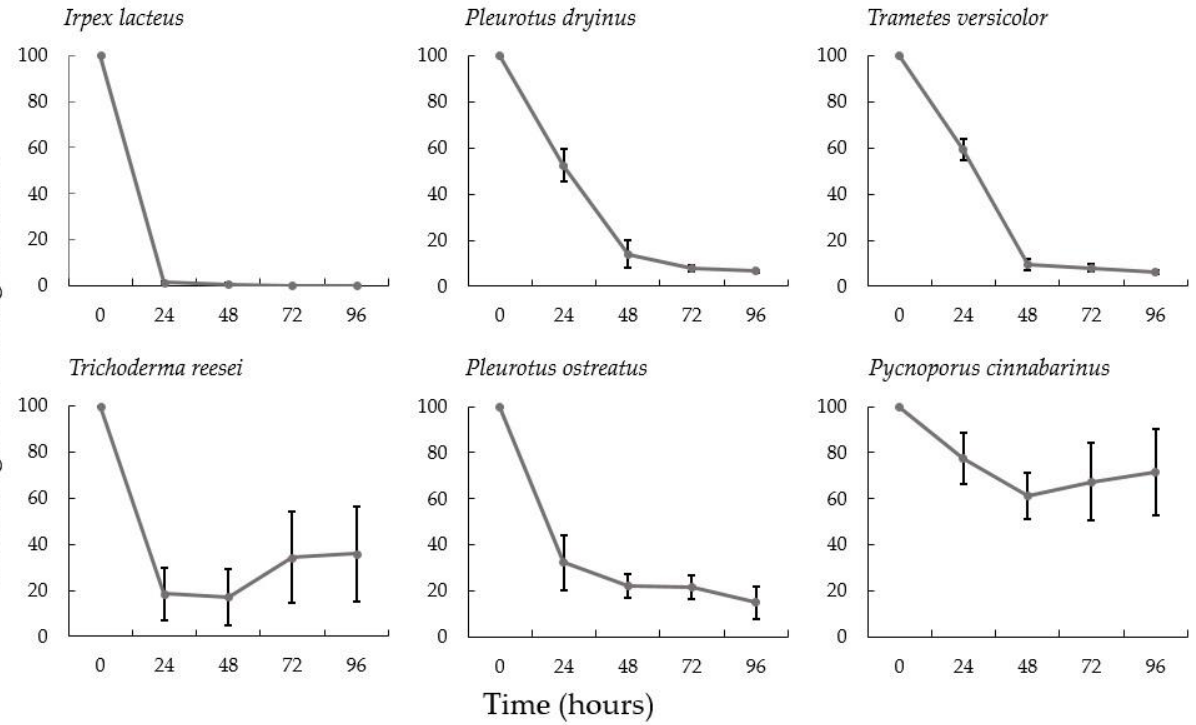
Figure 1. Percentage of suspended T. obliquus when selected fungal species were used for bio-flocculation. Standard deviation represents the average from three replicates.